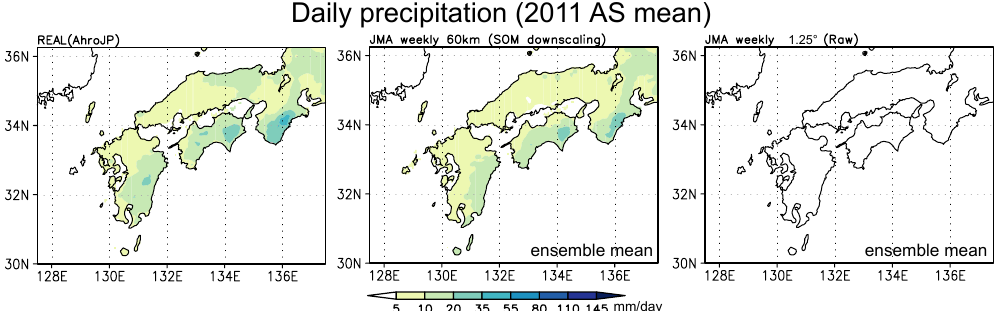
Figure 2. (a) Daily mean precipitation (mmday − 1 ) for observed, downscaled EPS (ensemble mean), 60km EPS raw (ensemble mean).